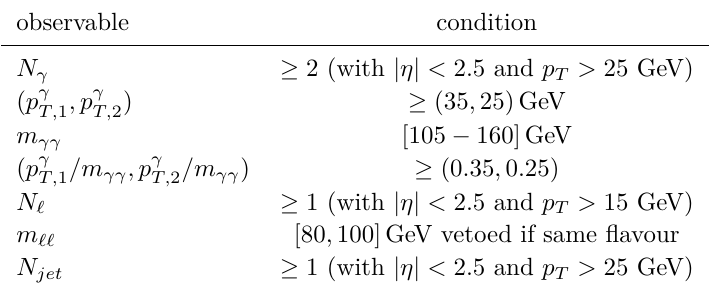
Table 1 . Summary of preselection